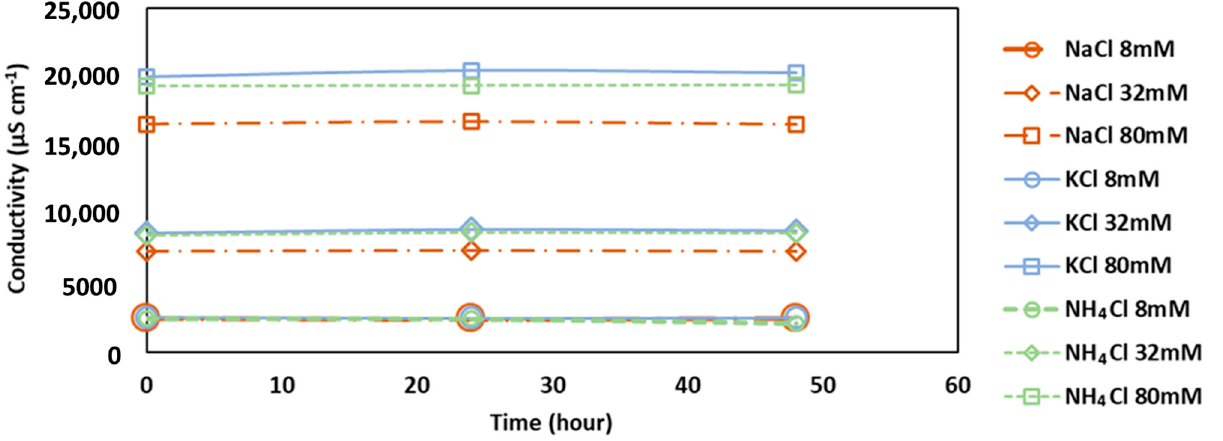
Figure 4. Conductivity changes of FS over time for the addition of NaCl, KCl and NH 4 Cl under different salt concentrations. Original algae conductivity was 750 ± 50 µS cm − 1.